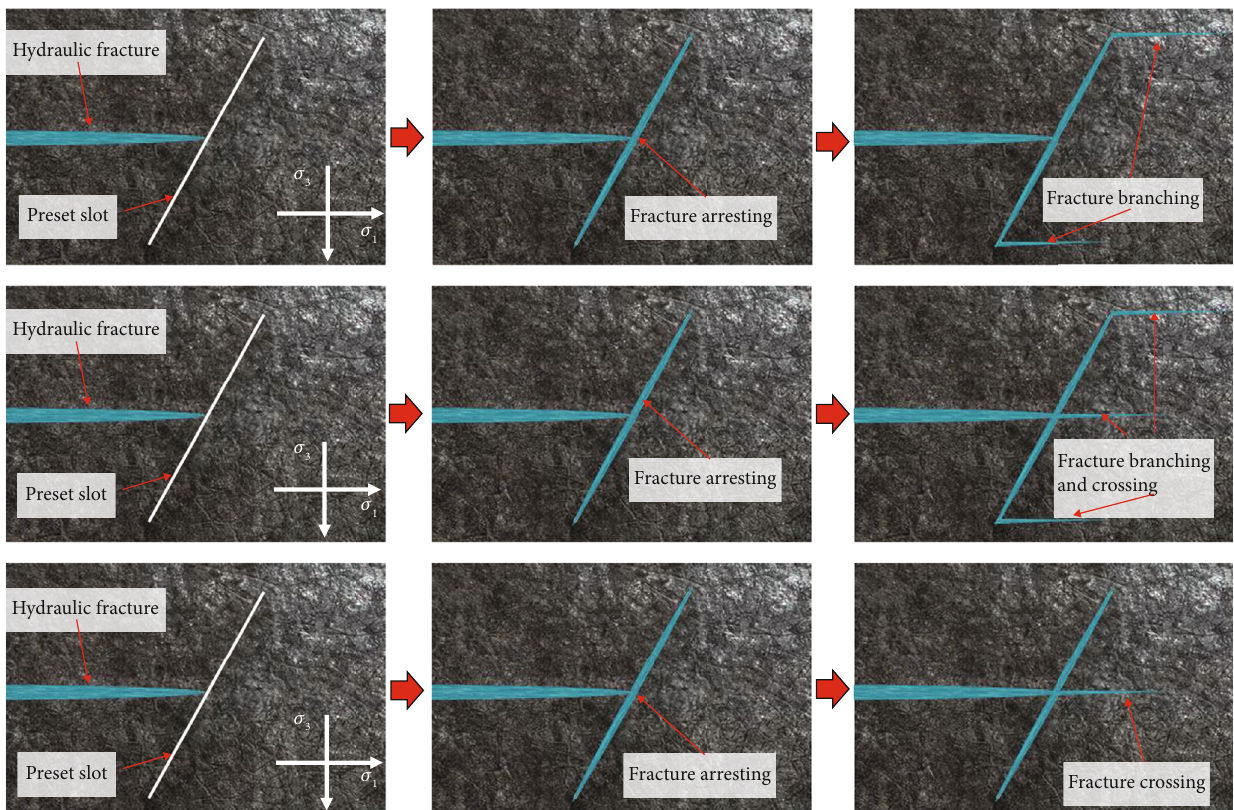
Figure 7: Illustrations of the interaction processes between the hydraulic fracture and the preset slot.